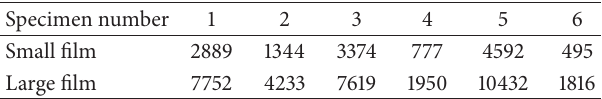
Table1:Thedistributionofexplodedballoonamongsmallandlarge pressure sensitive films.